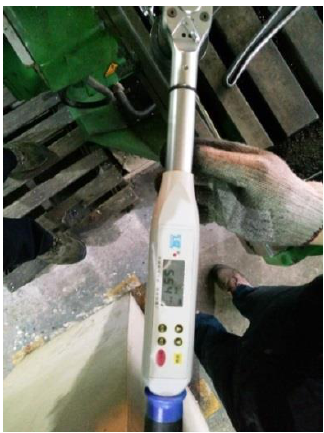
Figure 3. Experimental torque-preload curves of three bolts (M8 × 1, GH4169).